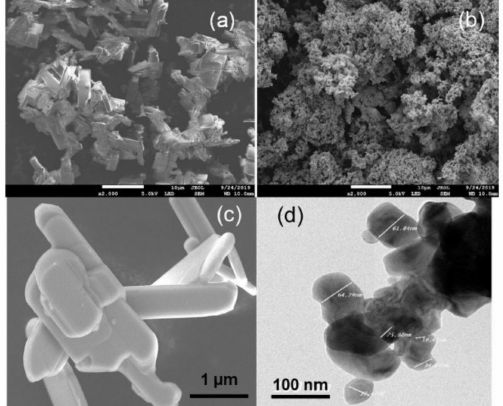
Figure 4. ( a , b ) SEM images of the MOA and MOV samples synthesized using a sol-gel method assisted by a biological chelator (scale bar of 10 µ m). ( c ) Magnified SEM image of the MOA (scale bar of 1 µ m) and a ( d ) TEM image of the MOV sample (scale bar of 100